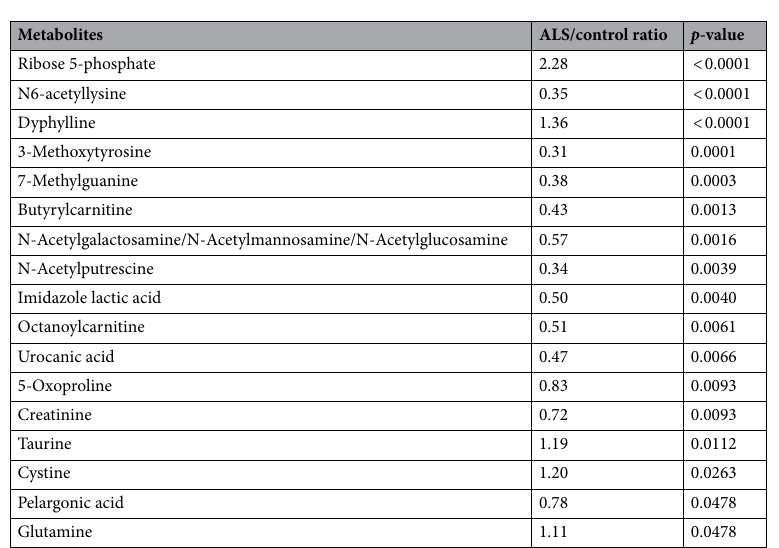
Table 3. Statistically significant metabolites in seven amyotrophic lateral sclerosis (ALS) patients vs 20 controls. P -values were obtained by Wilcoxon’s test, comparison of ALS patients and